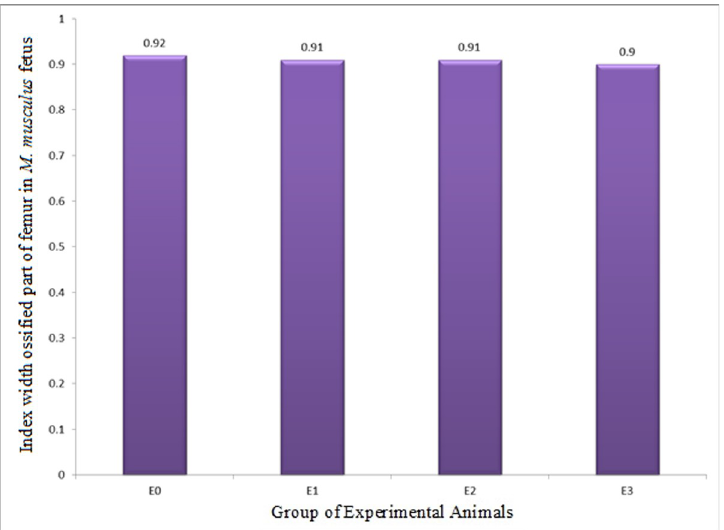
Fig 9. Index of width of ossified part (growth in diameter, IWOP) of femur in M . musculus fetuses on gestation day (GD) 18 which previously were given 0.39 mg/g bw LE3H through gavage on GD 10 (E1), injected with 5 mg/ kg bw HgCl 2 on GD 9 (E2), and administered 5 mg/kg bw HgCl 2 on GD 9 and then 0.39 mg/g bw LE3H on GD 10 (E3). Meanwhile, the controls (E0) were administered double-distilled water only.